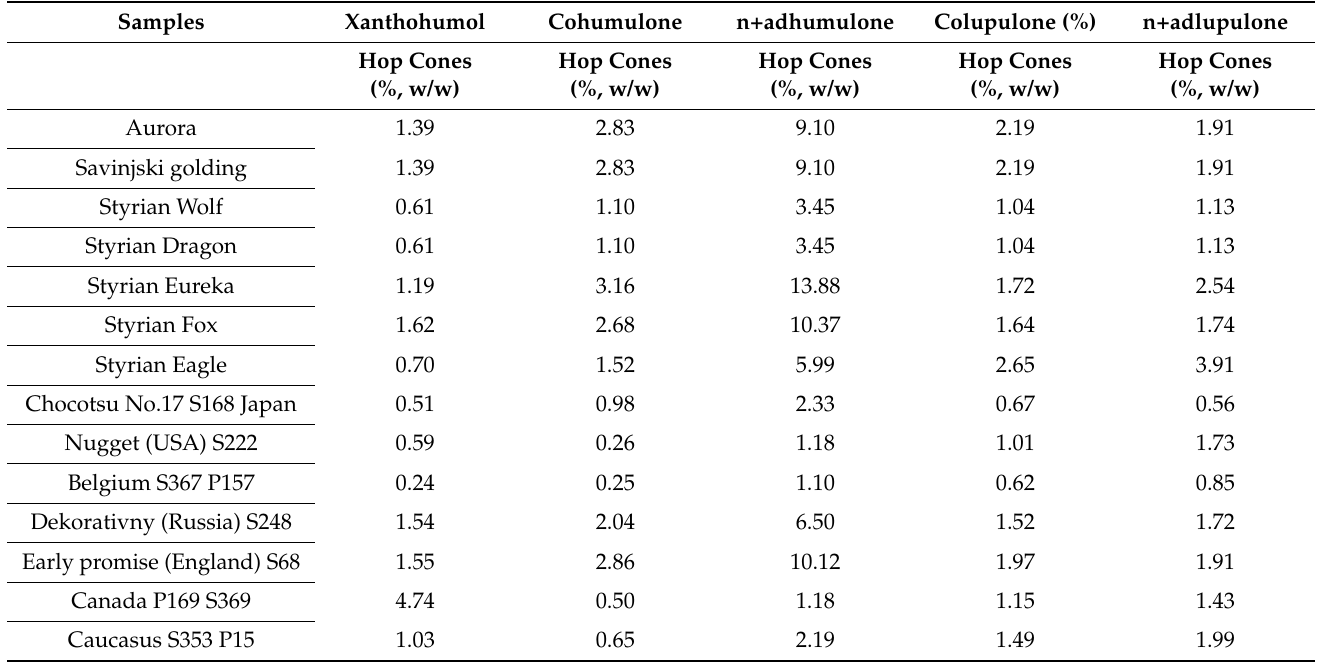
Table 1. The chemical composition of pure hop cones of different hop varieties included in our study, evaluated by